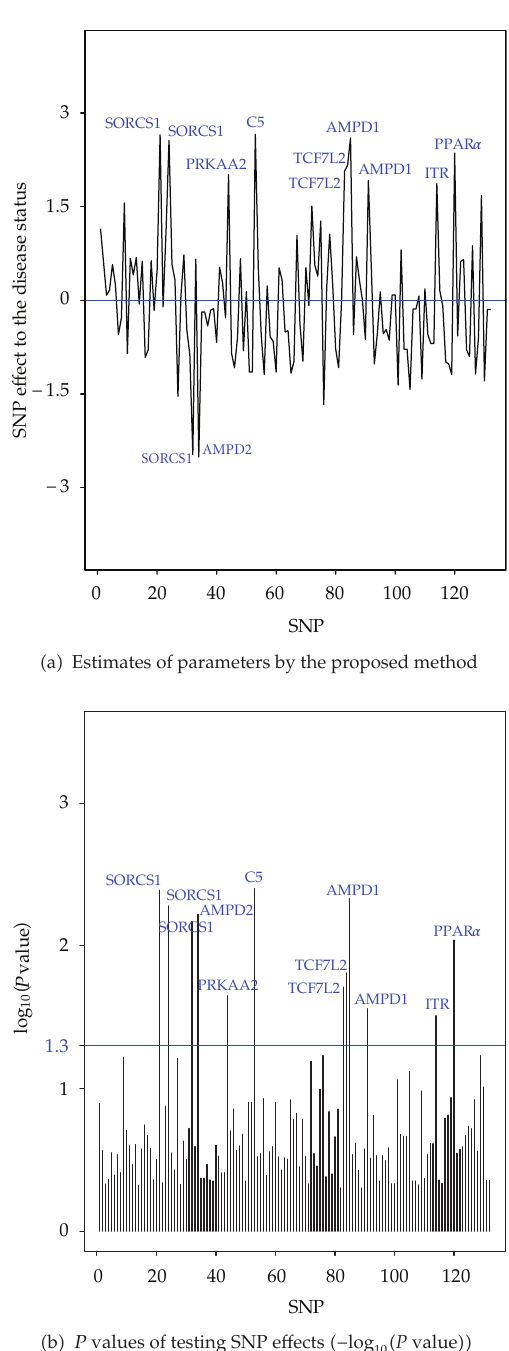
Figure 5: Analysis of Genes for IGT/IFG through IGT pathway (cid:2) Data Set D1 (cid:3) with multinomial ordinal probit model with